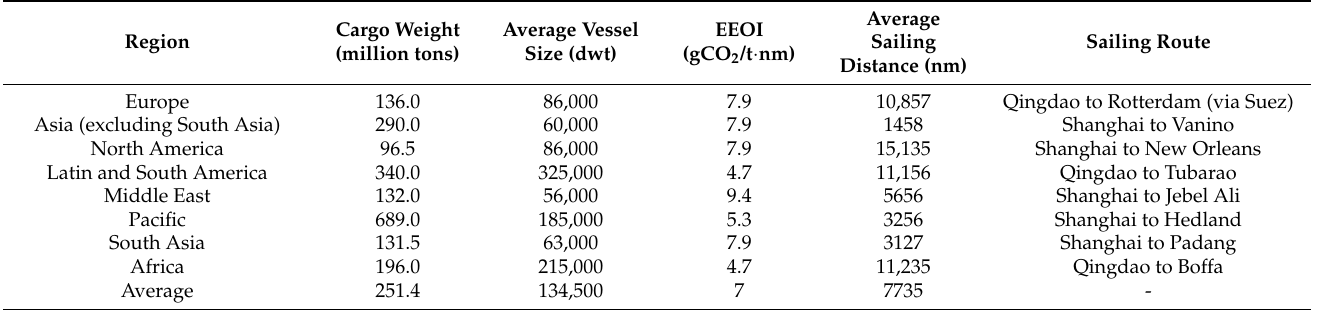
Source: The columns of ‘cargo weight’, ‘average vessel size’, ‘average sailing distance’, and ‘sailing route’ were provided by COSCO, and the EEOI values for ships are based on the Fourth Greenhouse Gas Study published